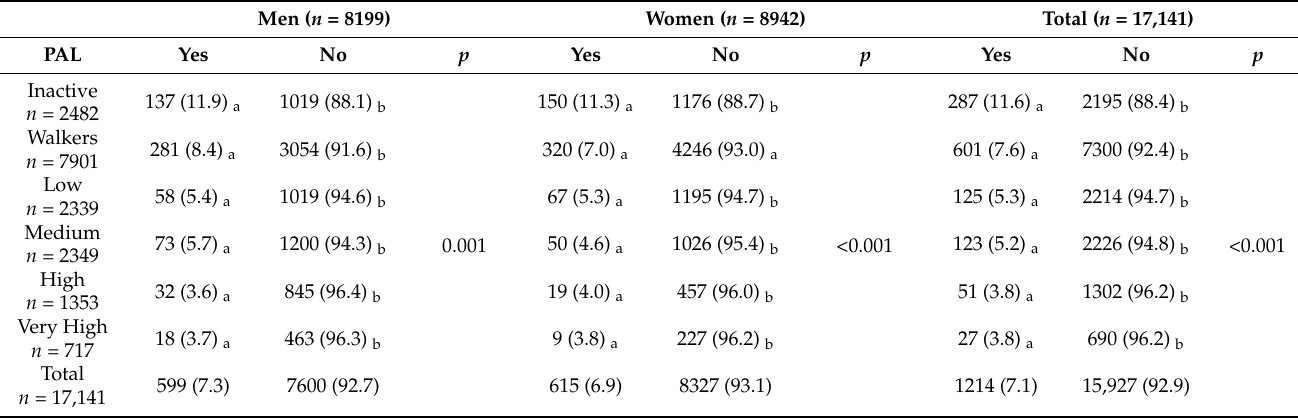
Table 3. Associations between the hospitalisation prevalence and physical activity level in the general Spanish population aged 18–69 years compared by sex, according to the ENSE 2017.